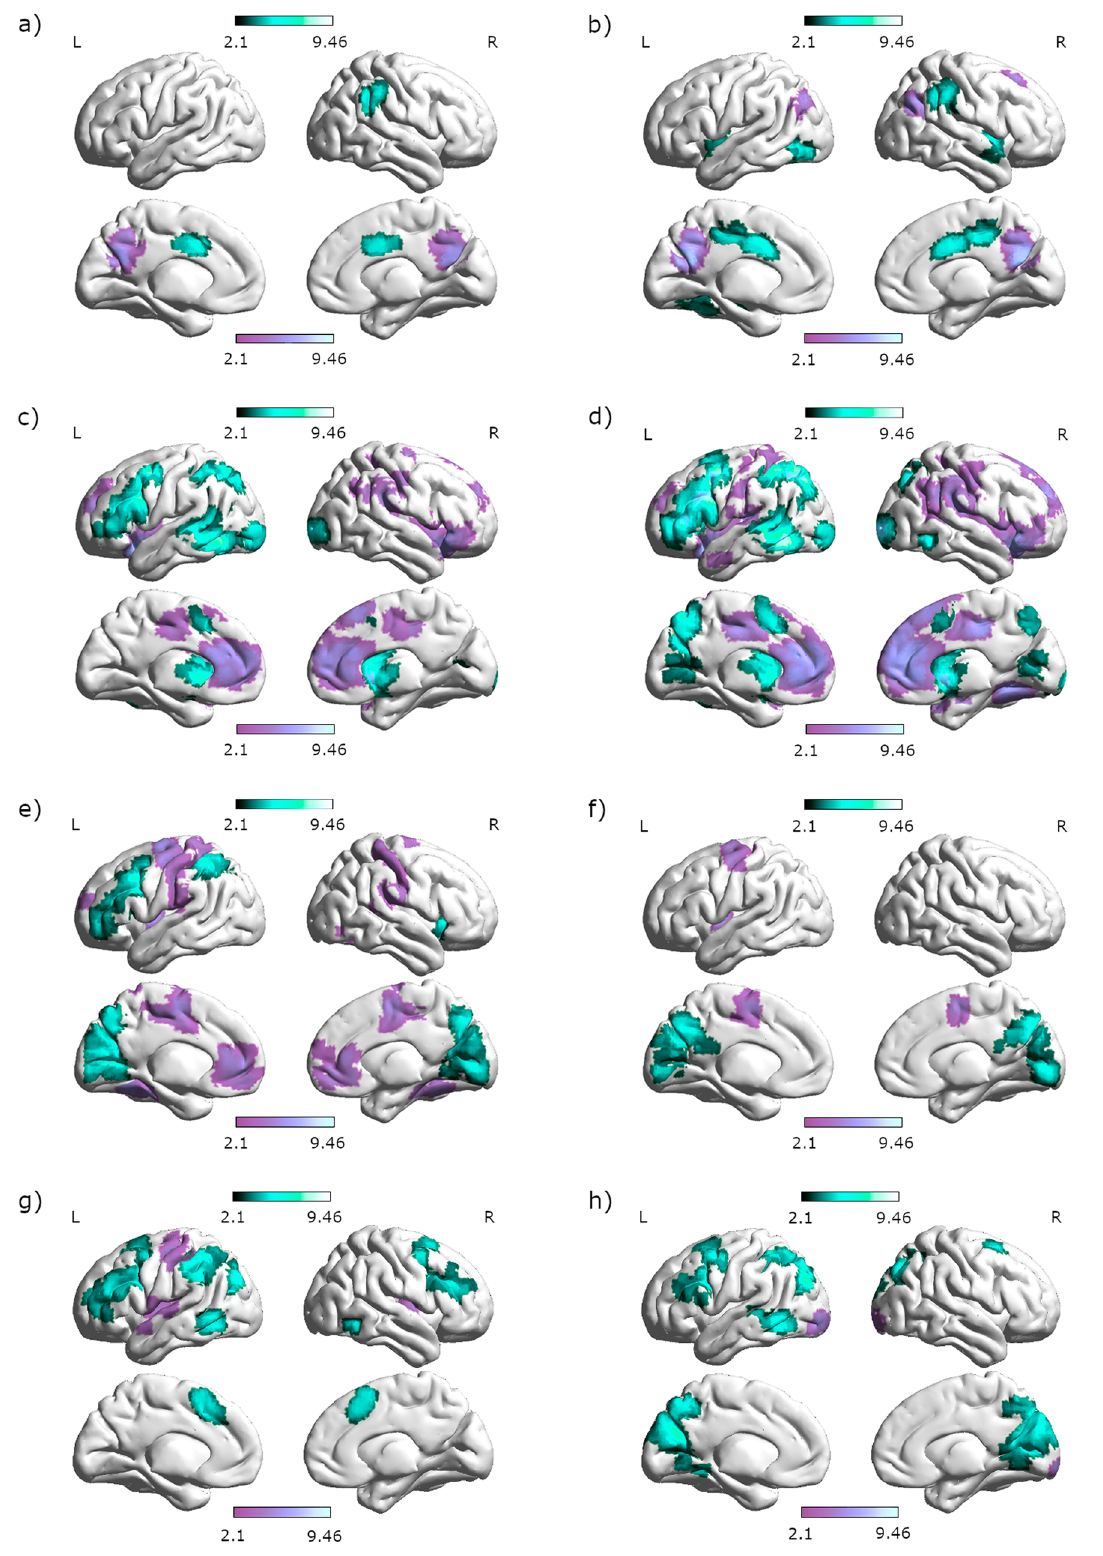
Fig. 5 Areas with differential connectivity during allocentric and egocentric navigation. Areas with stronger connectivity for allocentric compared to egocentric navigation are displayed in turquoise. Areas with stronger connectivity for egocentric compared to allocentric navigation are displayed in purple. Seed regions: a left hippocampus, b right hippocampus, c left caudate, d right caudate, e left retrosplenial cortex f right retrosplenial cortex, g left primary visual cortex, h right primary visual